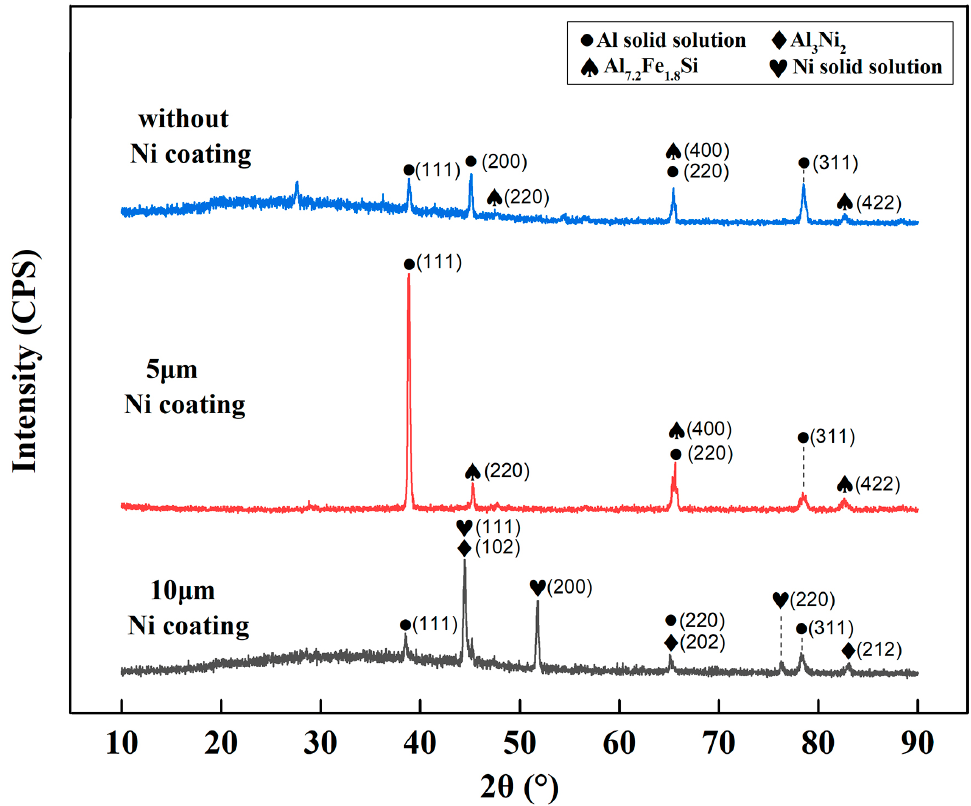
Figure 5. XRD results of Al alloy/steel joints. Based on the above investigations, using AlSi12 filler metal to join Al alloy and steel by CMT technology, the joint was mainly composed of α -Al solid solution and τ 5 -Al 7.2 Fe 1.8 Si in the fusion zone, and FeAl 3 together with θ -Fe (Si, Al) 3 in the interface reaction zone. After coating 5 µ m Ni on the steel surface, Ni participated in the metallurgical reaction, and reacted with Al, Fe, and Si elements to form some new phases of τ 5 -Al 7.2 (Fe, Ni) 1.8 Si and Al 3 Ni 2 in the fusion zone. Meanwhile, (Fe, Ni) Al 3 replaced FeAl 3 in the interface reaction zone. It can be predicted that the change in microstructure composition will improve the mechanical properties of the joints. When the Ni-coating thickness increased to 10 µ m, most of the Ni coating did not melt, so the diffusion between Al element and Fe element was blocked. Interestingly, the FeAl 3 phase disappeared, and a new phase of (Fe, Ni) 2 Al 3 appeared in the IMCs layer near the Al alloy. The interface reaction zone was mainly composed of α -Ni solid solution. Hence, the mechanical properties of the joint will not be